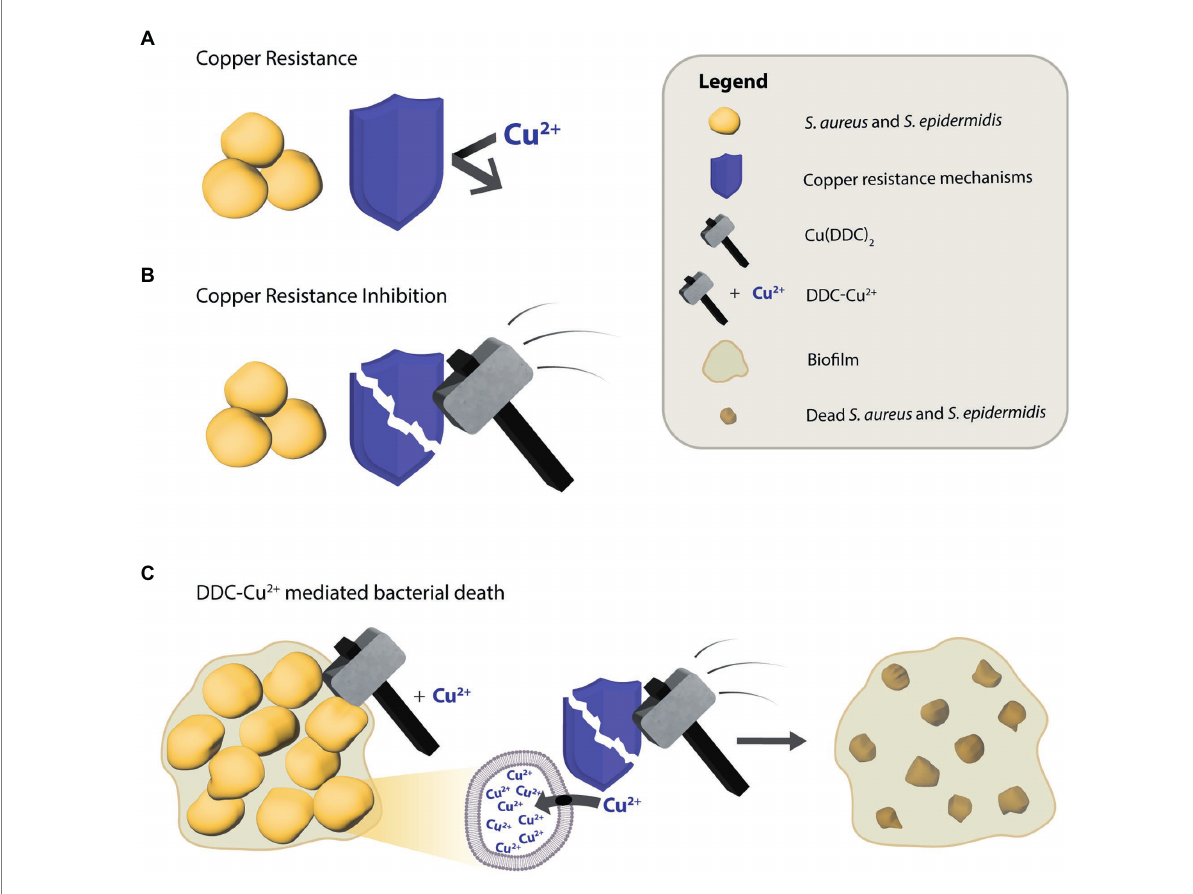
FIGURE 6 Putative diethyldithiocarbamate and copper (DDC-Cu 2+ ) mode of action against S. aureus and S. epidermidis . (A) The antibacterial activity of Cu 2+ is limited by copper resistance mechanisms of bacteria. (B) The Cu(DDC) 2 complex inhibits the bacterial copper resistance mechanism but does not kill bacteria. (C) The combination of Cu(DDC) 2 complex and excessive Cu 2+ (called DDC-Cu 2+ ) effectively kills bacteria, as the Cu(DDC) 2 complex inhibits the copper resistance mechanisms, allowing for the excess Cu 2+ to increase copper induced